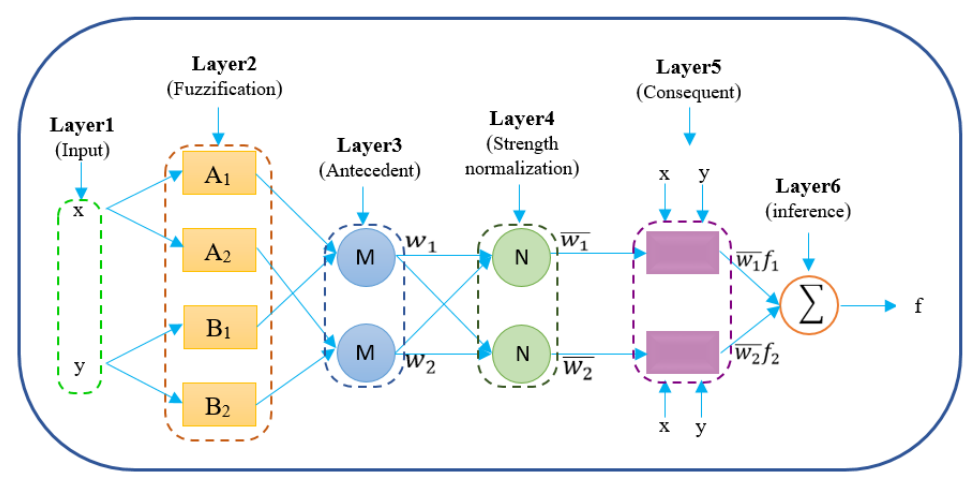
Figure 2. The structure of the adaptive neural fuzzy inference system.